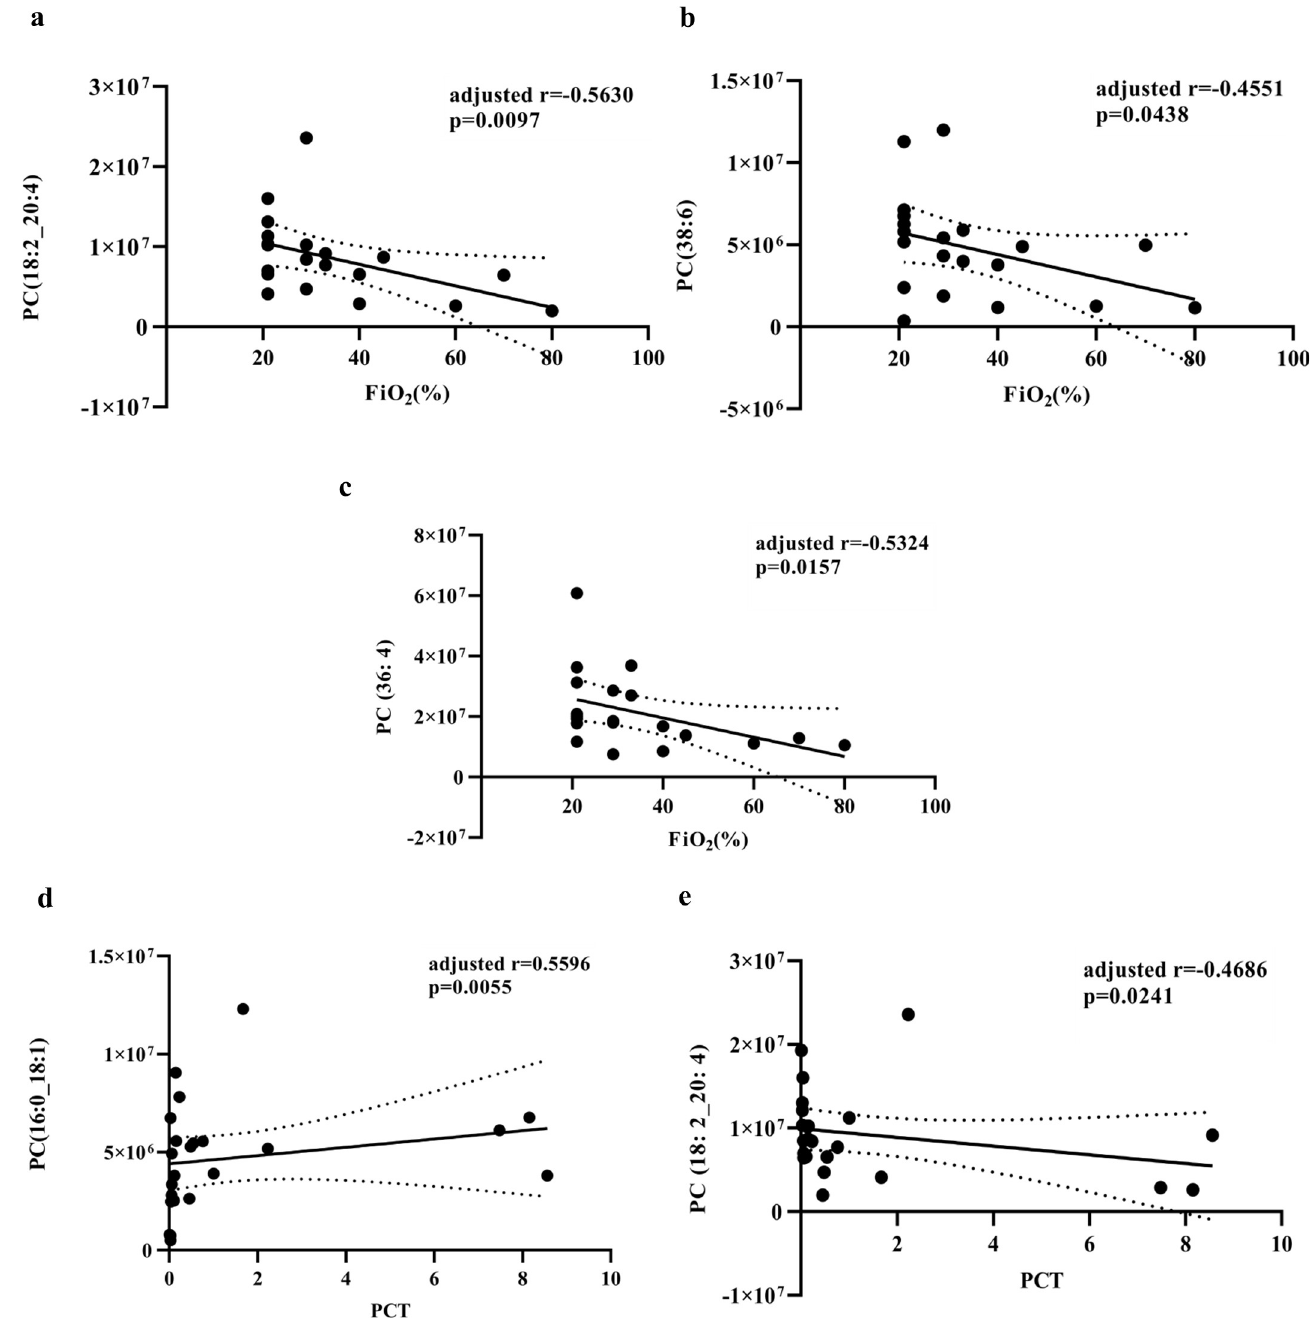
Fig 4. The relative levels of PC (16:0_18:1), PC (18:2_20:4), PC (38:6), and PC (36:4) show significantly correlations with clinical indicators. (a-c) The relative levels of PC (18:2_20:4) PC (38:6) and PC (36:4) were inversely correlated to FiO 2 of patients with CAP. (d) The abundance of PC (16:0_18:1) had a positive linear relationship with PCT (e) The abundance of PC (18:2_20:4) was negatively correlated with PCT of CAP patients. Solid black line, the fitted regression line. Area within the dotted line lines, the 95% confidence intervals.